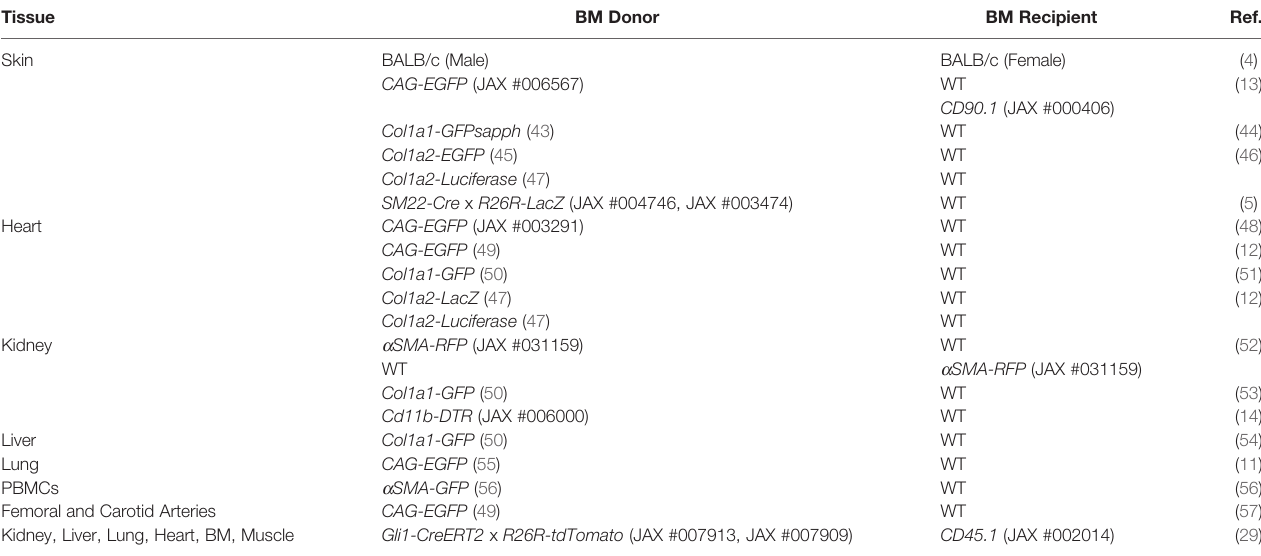
TABLE 2 | BM chimera models.